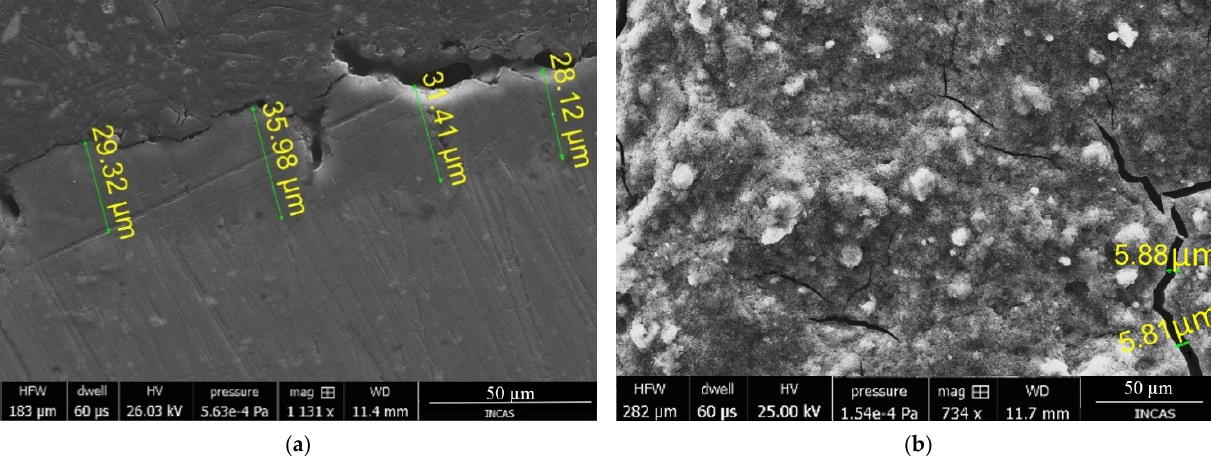
Figure 9. SEM micrograph of the cross section of the sample based on corundum blasted substrate before testing: ( a ) paint thickness measurements in different places; ( b ) measurements of cracks on the surface of the coating.